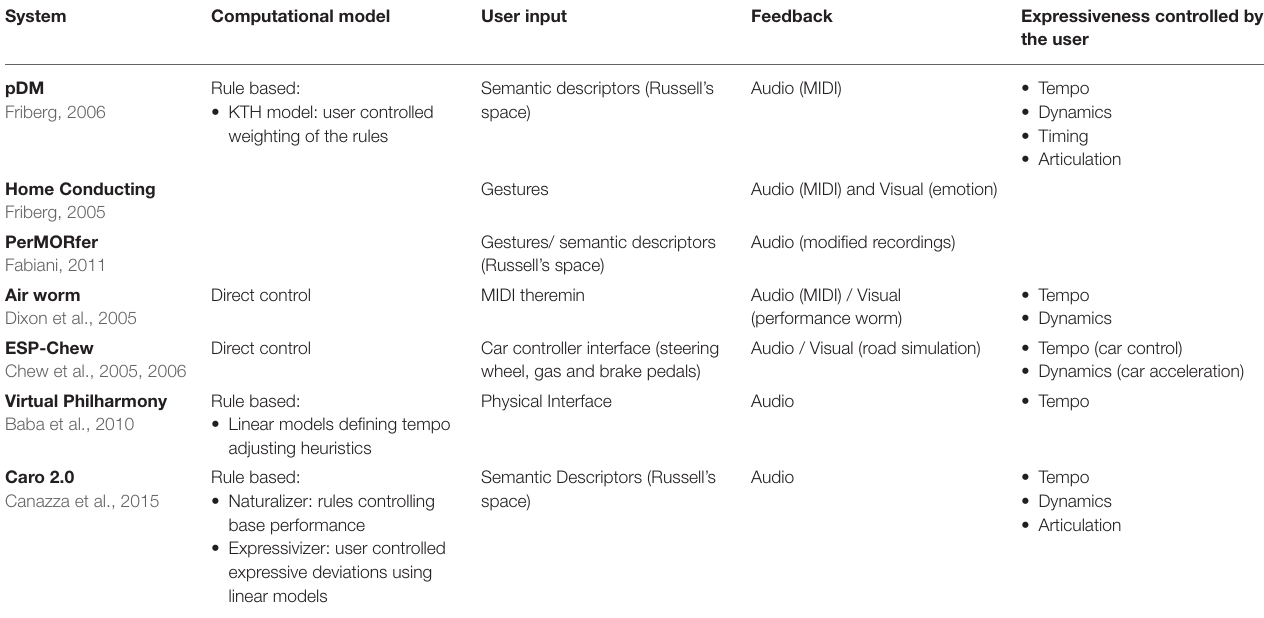
TABLE 3 | Feedback and conductor